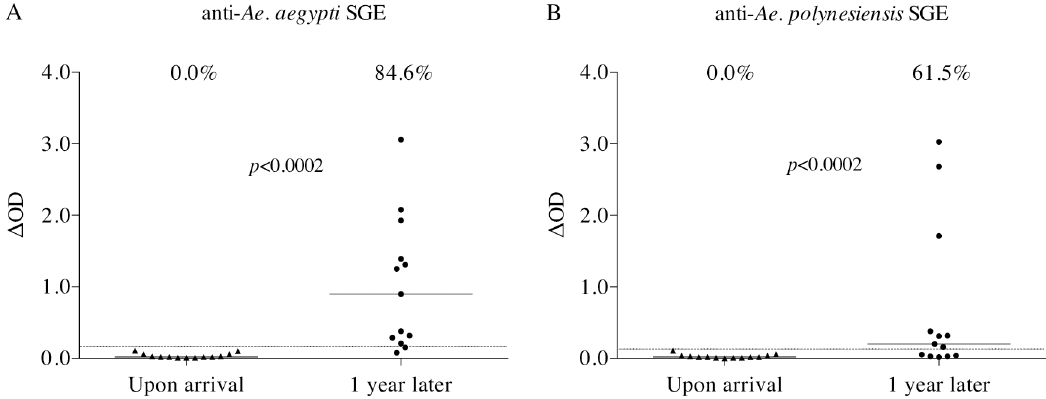
Fig 2. Evolution of antibody responses to Ae . aegypti and Ae . polynesiensis SGE in military personnel. The figure presents individual IgG responses ( Δ OD)to Ae . aegypti (A) and Ae . polynesiensis (B) SGE of French military personnel (n = 13) assigned in Tahiti island (French Polynesia). Blood from the same individual was sampled two weeks after arrival and one year later (paired data). Each triangle or dot represents an individual serum and the horizontal bar indicates the median value. The dotted lines correspond to the positivity thresholds calculated from the cohort of metropolitan French residents (0.16 and 0.13 for Ae . aegypti and Ae . polynesiensis , respectively). Percentages of responders are shown above each plot. The non-parametric Wilcoxon test was used to compare the paired